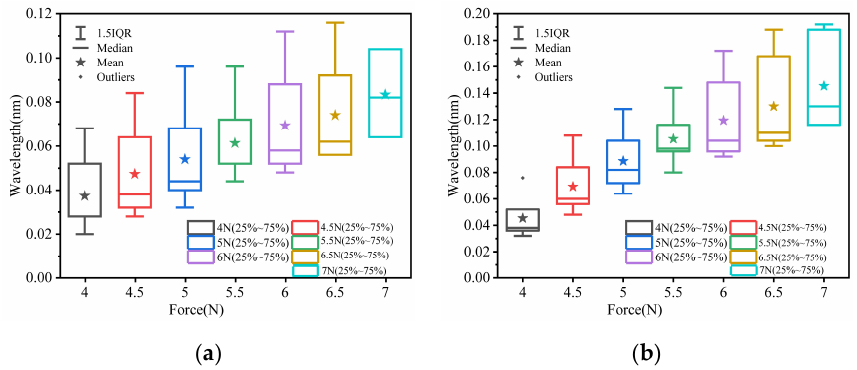
Figure 11. Repeatability analysis: ( a ) split point, ( b ) right peak.